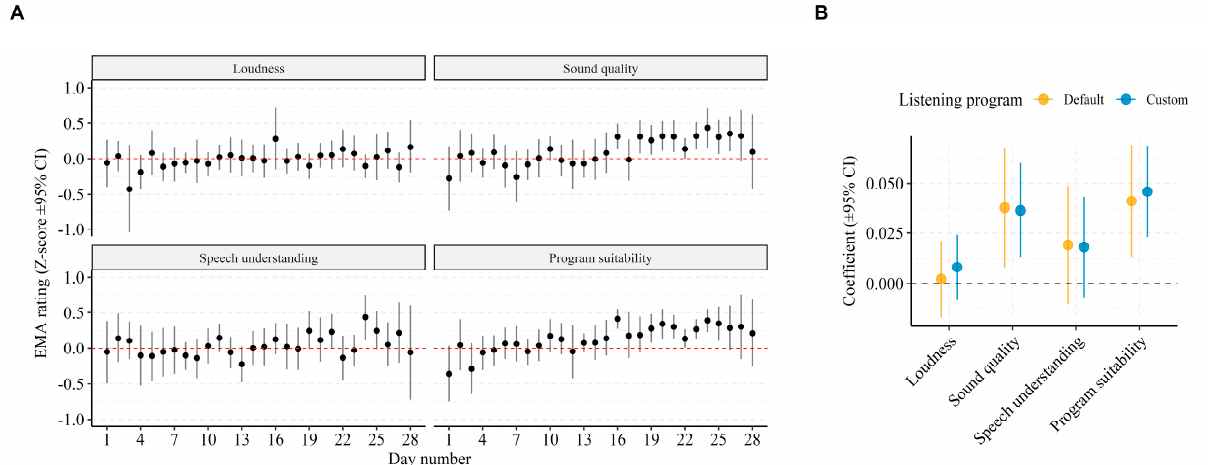
Figure 3. Acclimatization effect. ( A ) Grand average EMA ratings per day since field study start. The EMA ratings were individually z-score transformed prior to averaging to adjust for inter-individual variance. Red horizontal line at y = 0 indicates the overall mean rating. ( B ) Regression coefficients for predicting change in EMA ratings by days since field study start. The coefficients are computed by LME models adjusted for random slopes and intercepts by subjects.